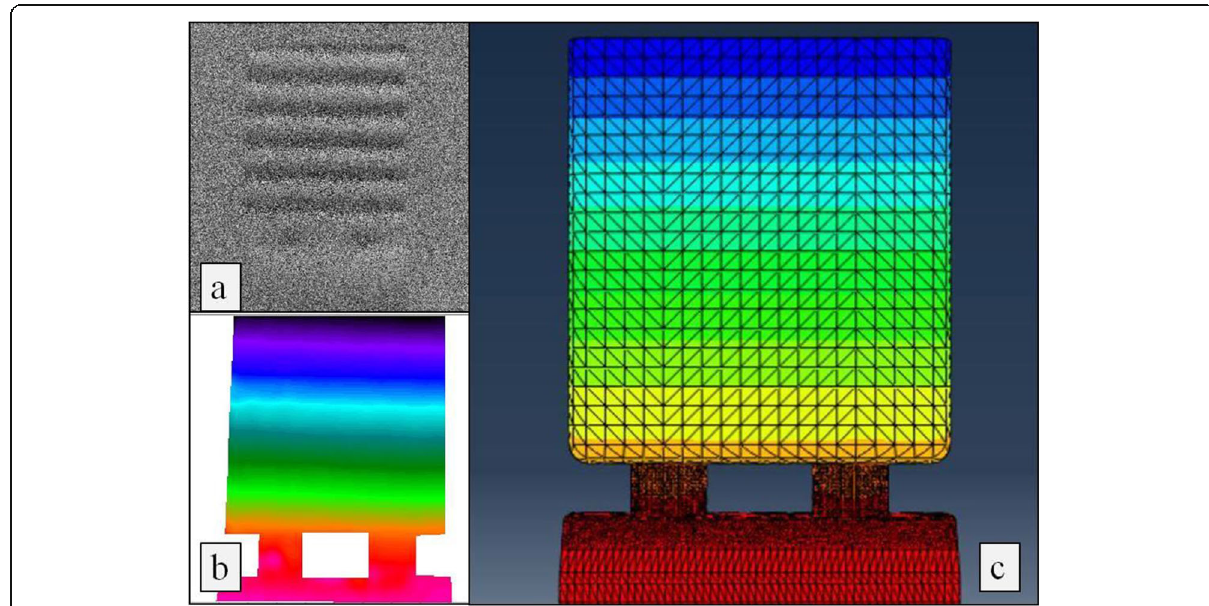
Fig. 7 Coincidence of displacements calculated with ESPI and FEA. The ESPI results may be visually translated by a fringe pattern that represents the displacement field of the surface under study: a Its transduction into a colour code ( b ) results in an image similar to the obtained on FEA ( c ), facilitating the comparison between both models ’ results